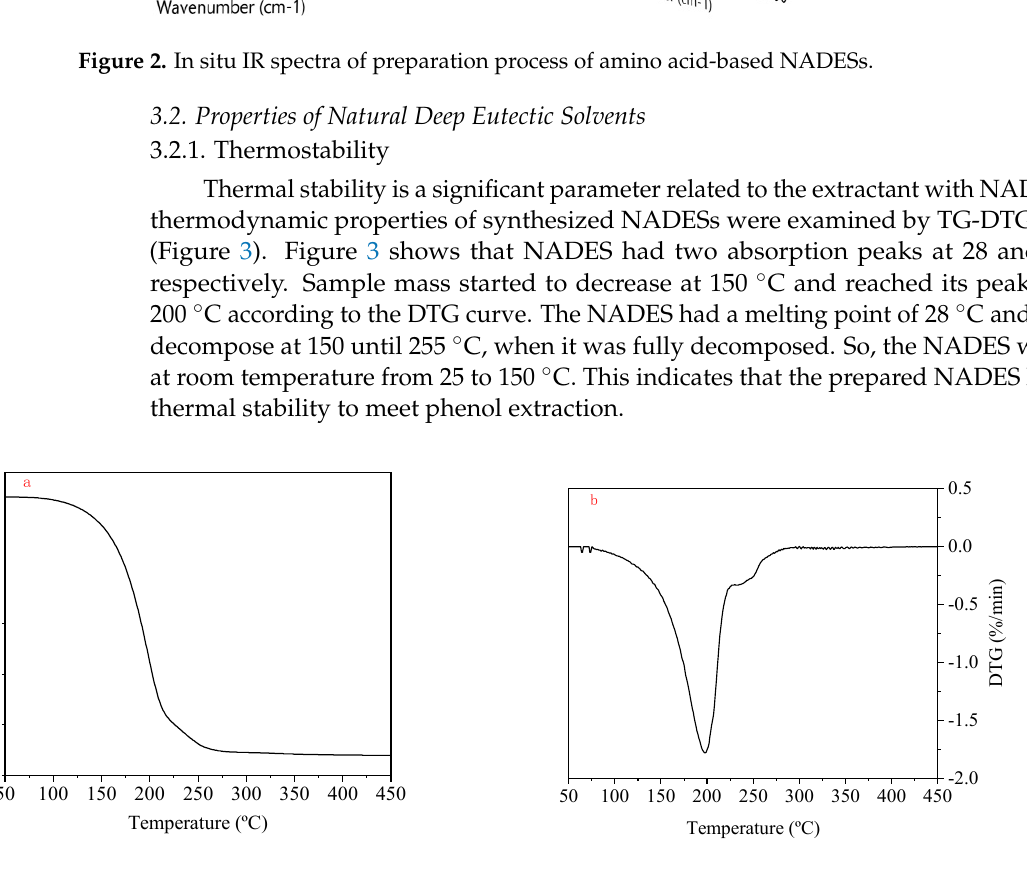
Figure 3. ( a ) TG (in nitrogen) curves of NADESs; ( b ) DTG (in nitrogen) curves of NADES (decanoic acid: L-Pro:4.2:1).